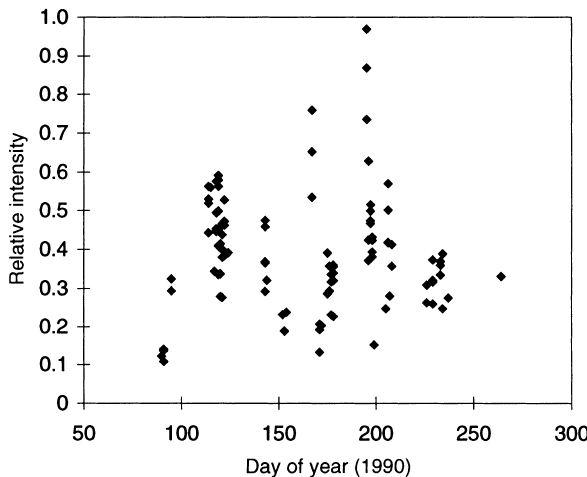
Fig. 5. Seasonal OH(6–2) emission intensity variation for the principal data set (solar altitude < (cid:255) 18 (cid:14) , lunar altitude < 0 (cid:14) , no cloud, OI < P 1 (cid:133) 3 (cid:134) , 104 spectra) as a function of day of year, 1990.